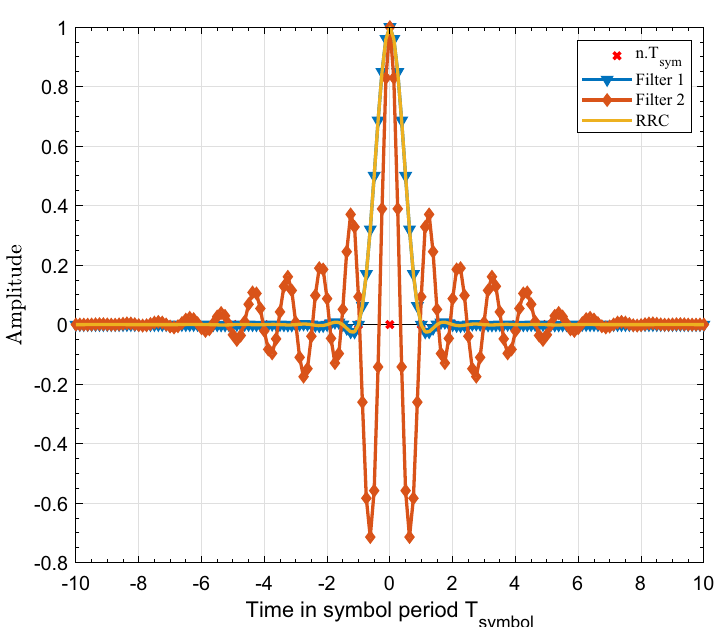
Fig. 7 Output of the correct matched filter at the receiver side for RRC and the 2 designed IQ-FSIM filters having same η = 10 and (cid:31) =